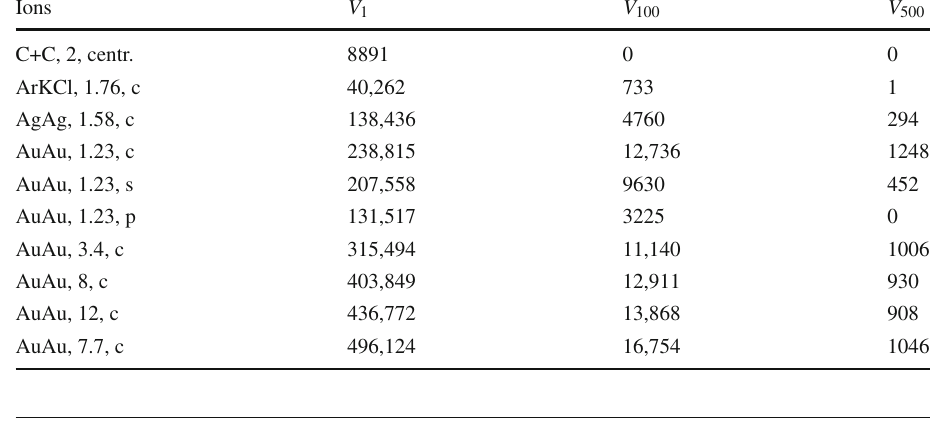
Table 14 Results for X < 0 . 5 and Y < 0 .